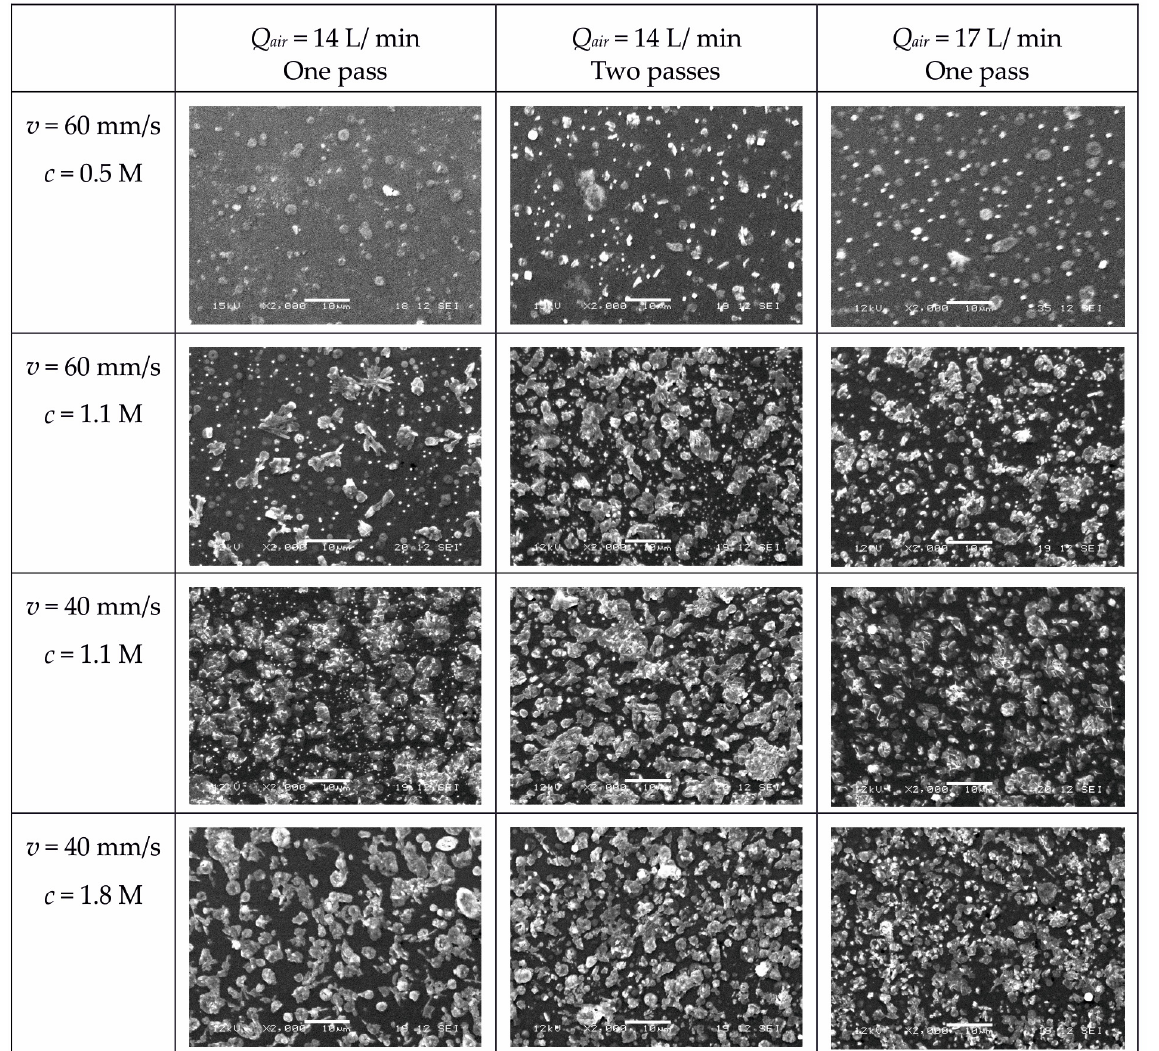
Figure 2. SEM images with a magnification of 2000 × (scale bar 10 µ m) of the coated glass surfaces at different deposition parameters.